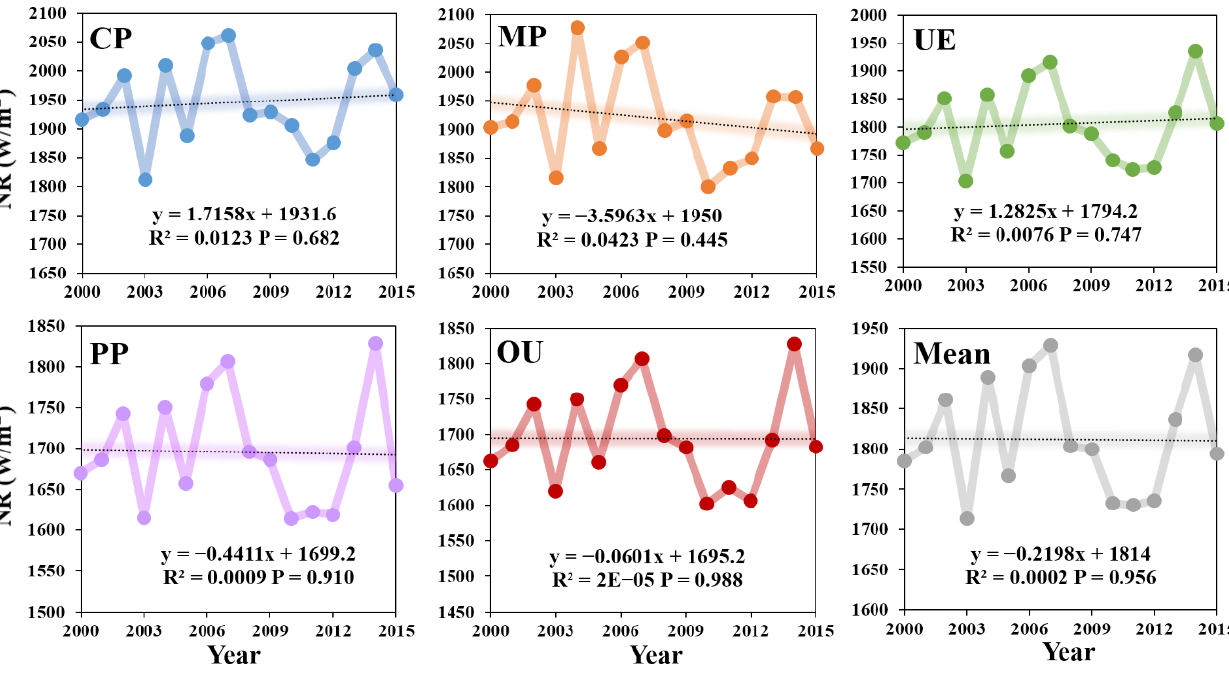
Figure 8. Mann – Kendall test of net radiation (NR) for different land use types in the Huang-Huai- Hai River Basin from 2000 to 2015. 3.2. Analysis of Surface Energy Balance 3.2.1. Changes in Surface Energy Consumption It can be seen from Figure 9b, the change values of LH in the Huang-Huai-Hai Basin from 2000 to 2015 was positive. From the spatial distribution point of view, the overall LH